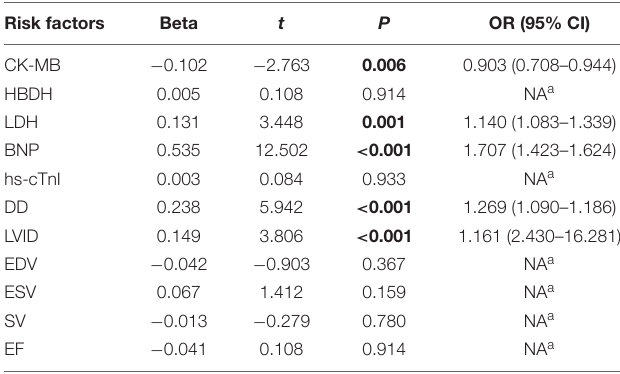
TABLE 3 | Clinical and echocardiographic characteristics of matched AL and control group patients. Variable Matched control Matched patients group with